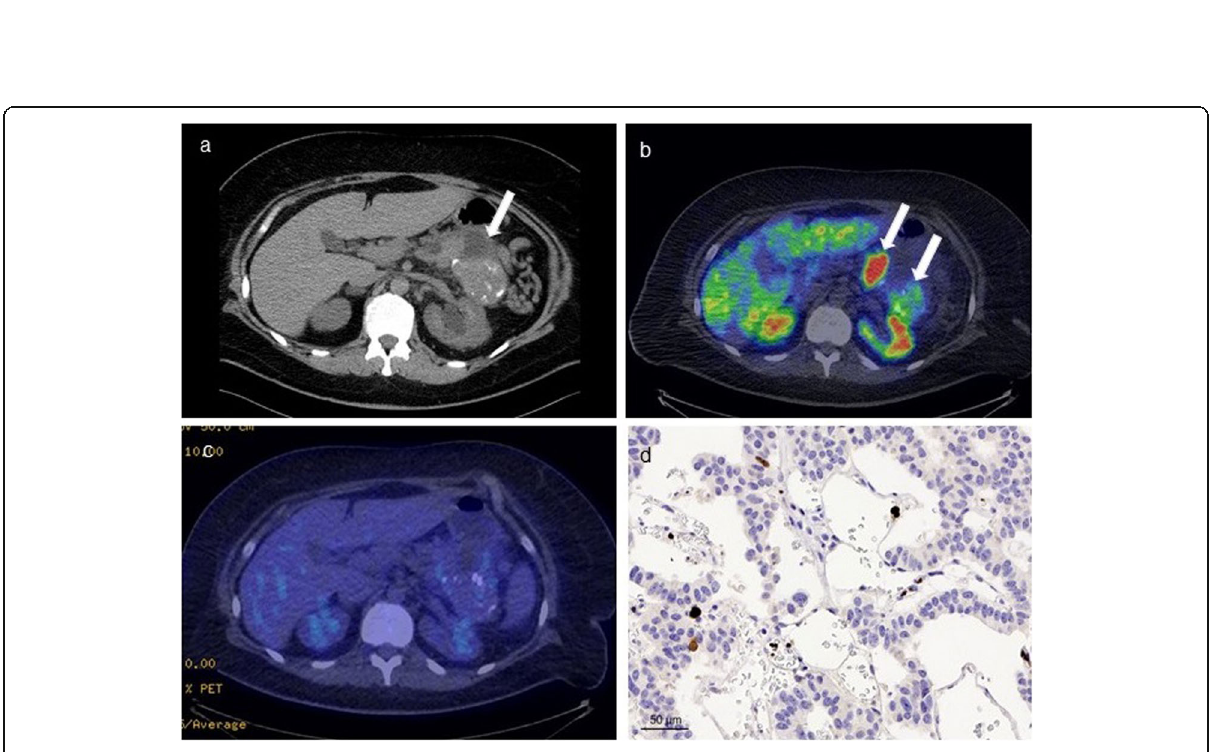
Fig. 5 A 32-year-old female patient had a 10 cm complex cystic-solid mass in the tail of the pancreas on CT ( a ). 68 Ga-DOTANOC-PET/CT ( b ) showed two different uptake intensity areas around a large cystic component (SUV max 29 g/ml and 10.6 g/ml) in the pancreatic tumor. 18 F-FDG- PET/CT ( c ) was negative (SUV max 3.2 g/ml). She underwent a distal pancreatectomy and splenectomy and histopathological analysis revealed a G1 PNET (Ki-67 < 2%) ( d , image magnification × 40) with five lymph node